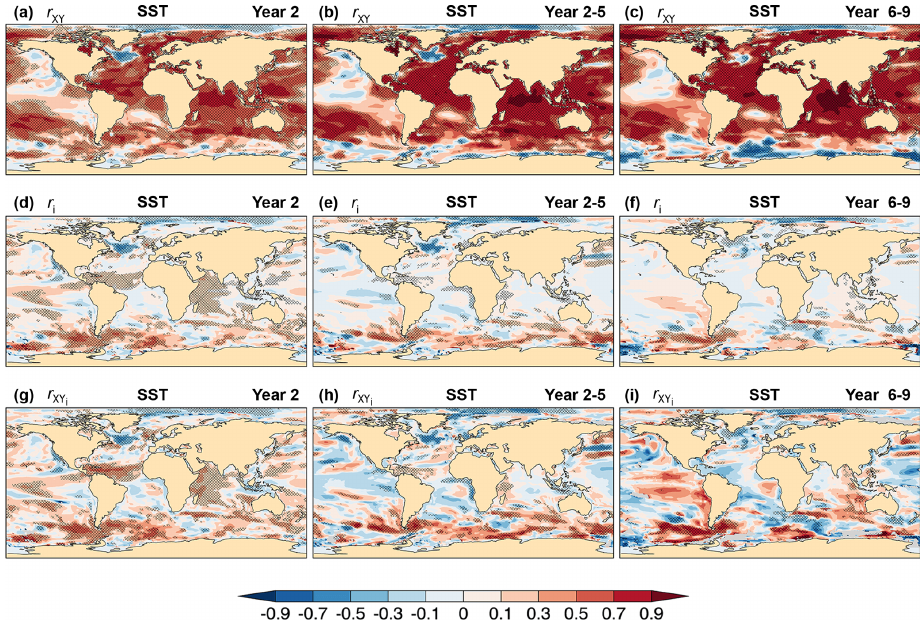
Figure 5. Skill of CanESM5 annual and multi-year mean sea surface temperature forecasts. (a–c) Correlation skill r XY , Eq. (6), (d–f) con- tribution from initialization r i to correlation skill, Eq. (A17), and (g–i) correlation skill of the initialized component of the forecast r XY Eq. (A19), for forecast (a, d, g) Year 2, (b, e, h) Year 2–5, and (c, f, i) Year 6–9. The verifying observations are from the ERSSTv5 data set (Appendix B). Cross-hatched regions indicate values significantly different from zero at the 90% confidence level.